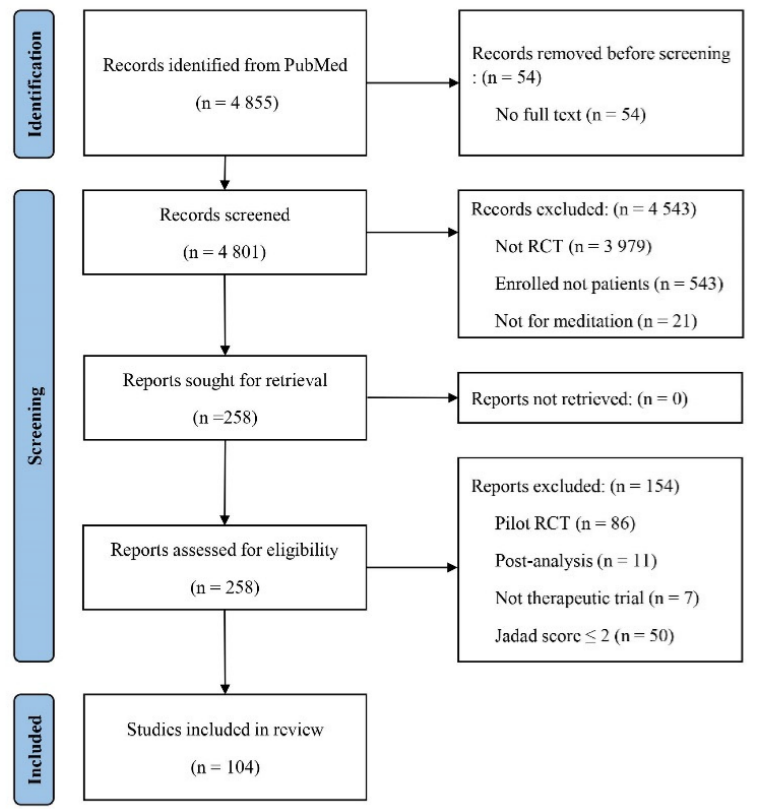
Figure 1. Flow chart of the study. Table 1. Study characteristics.